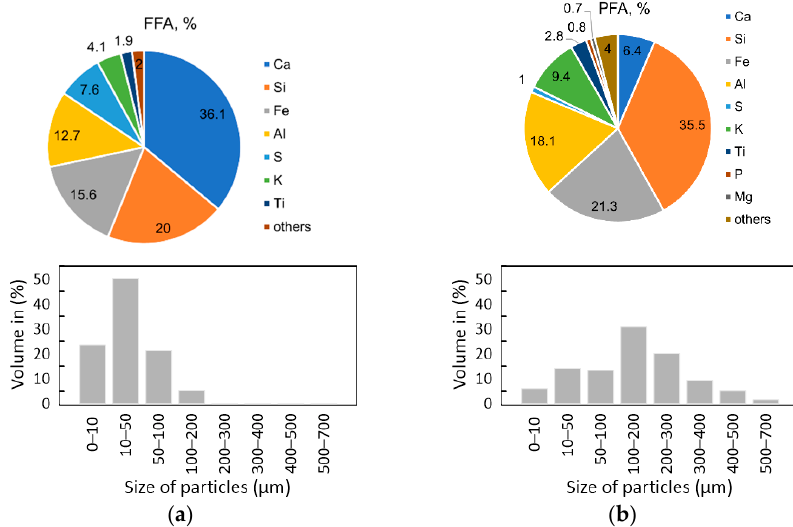
Figure 1. Chemical composition and particle size distribution of ( a ) FFA; ( b ) PFA.